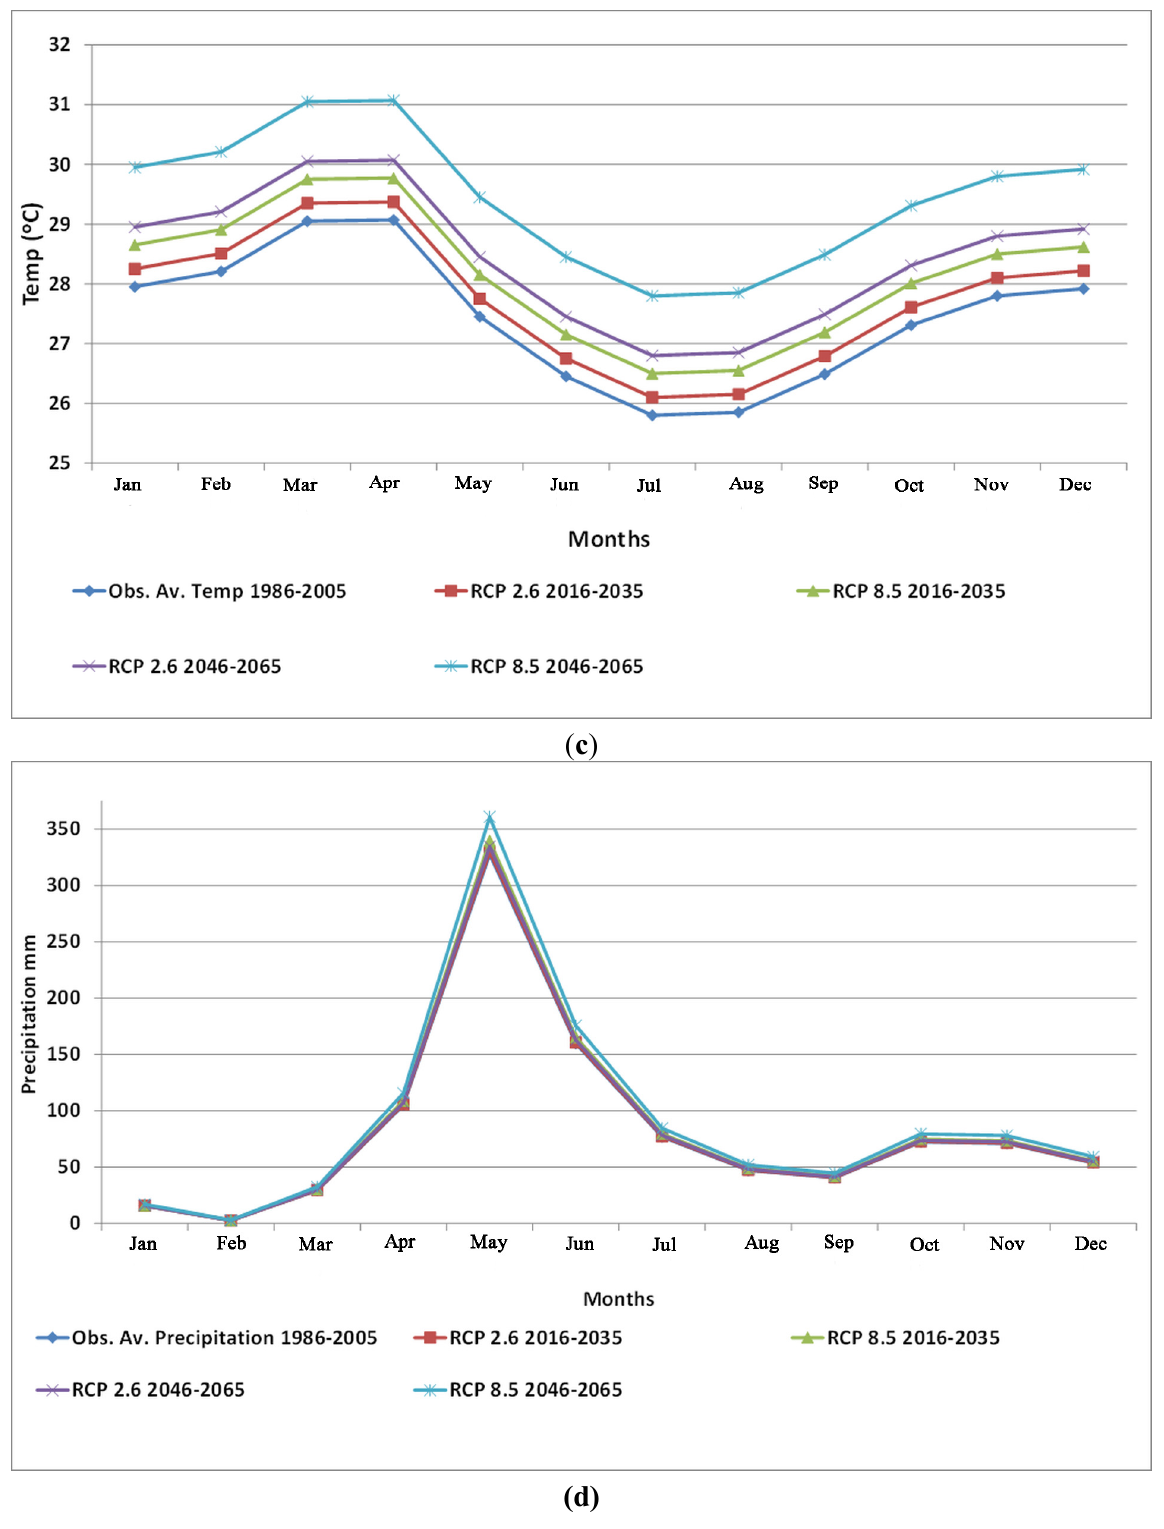
Figure 4. ( a , b ) Monthly temperature and precipitation projections for Special Report on Emissions Scenarios (SRES) A1b and A2 for 2031–2030 and 2051–2060 based on McSweeney’s [48] estimated changes and KMD climate data for 2000–2009; as well as ( c , d ) monthly temperature projections for Representative Concentration Pathways (RCP) 2.6 and 8.5 for 2016–2035 and 2046–2065 based on IPCC [38] estimated changes and Kenya Meteorological Department (KMD) climate data for